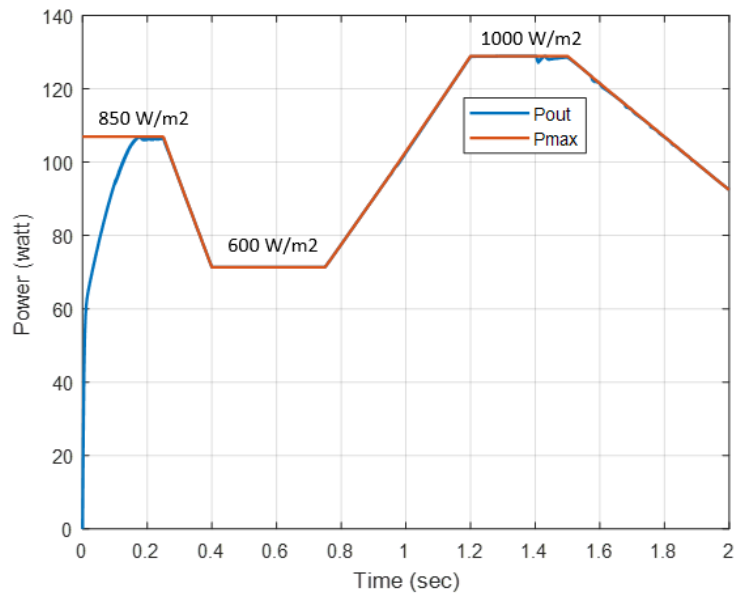
Figure 15. Output power vs. maximum power for a combination of step and ramp values of irradiance at 25 °C.